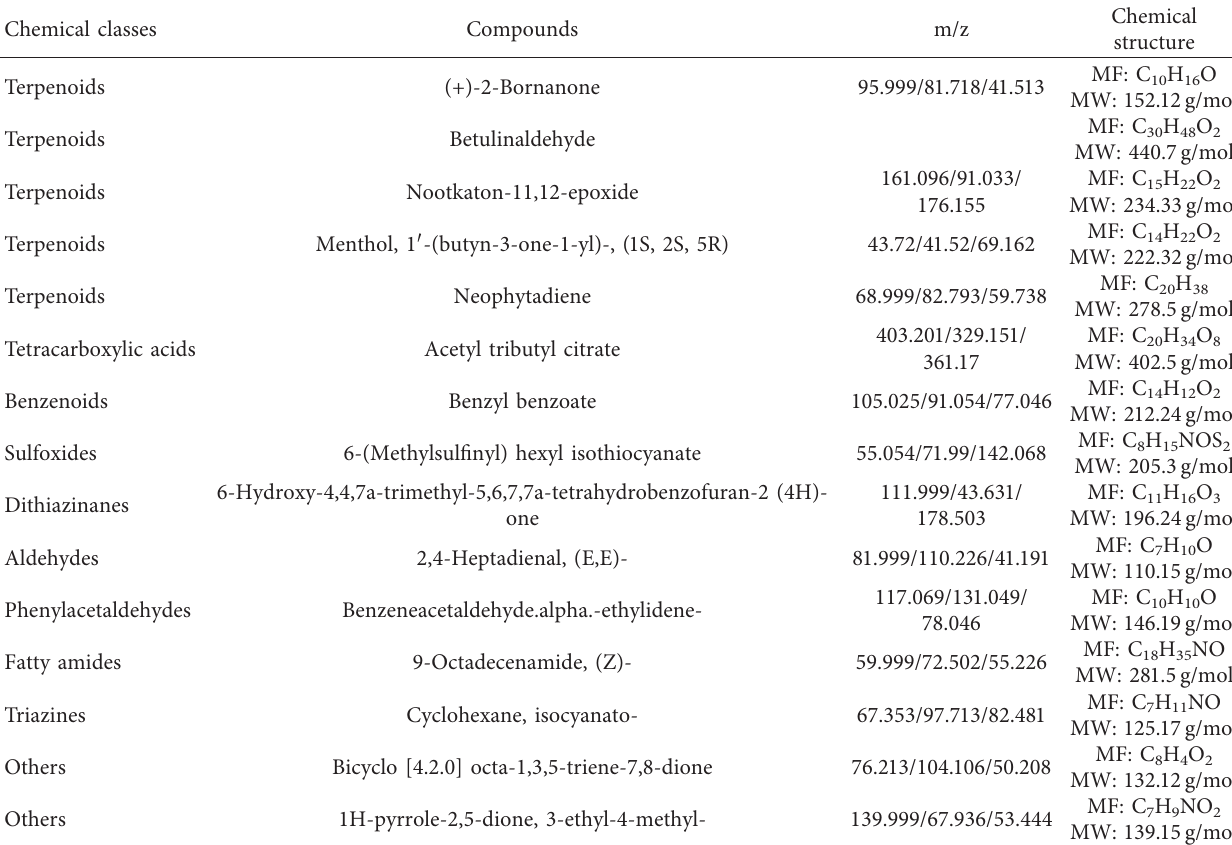
Figure 3: Compounds present in the flower, root and leave fractions of Lobularia maritima using GC-MS analysis. Table 7: Summary of the detected metabolites in Lobularia maritima